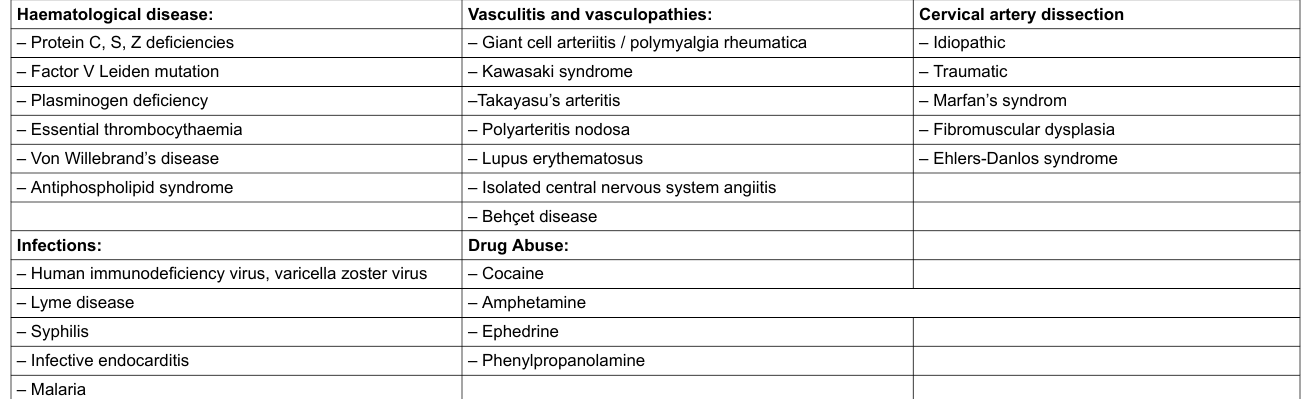
Table 1: Examples of “Other determined ischaemic strokes”. Adapted from Handbook of Clinical Neurology, Volume 93, Pages 1–982 (2008) Stroke Part II: Clinical Manifestations and Pathogenesis, Edited by Marc Fisher (ISBN: 978–0–444–52004–3). Haematological